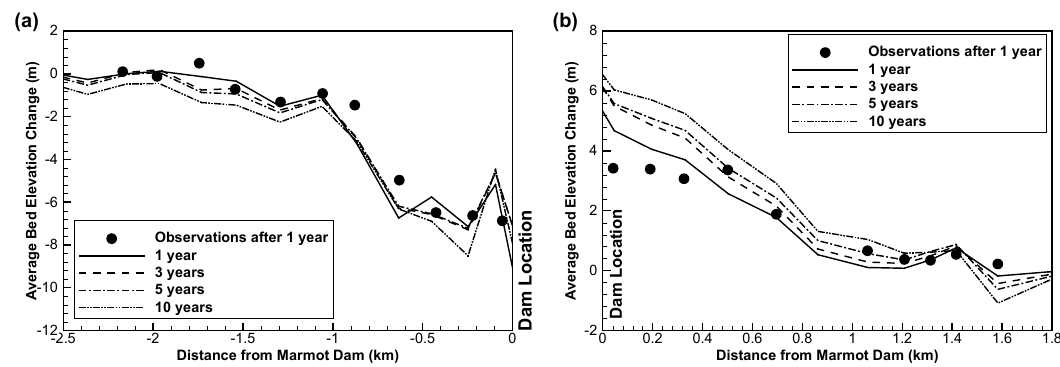
Fig. 5 Long-term bed change evolutions computed by using calibrated model